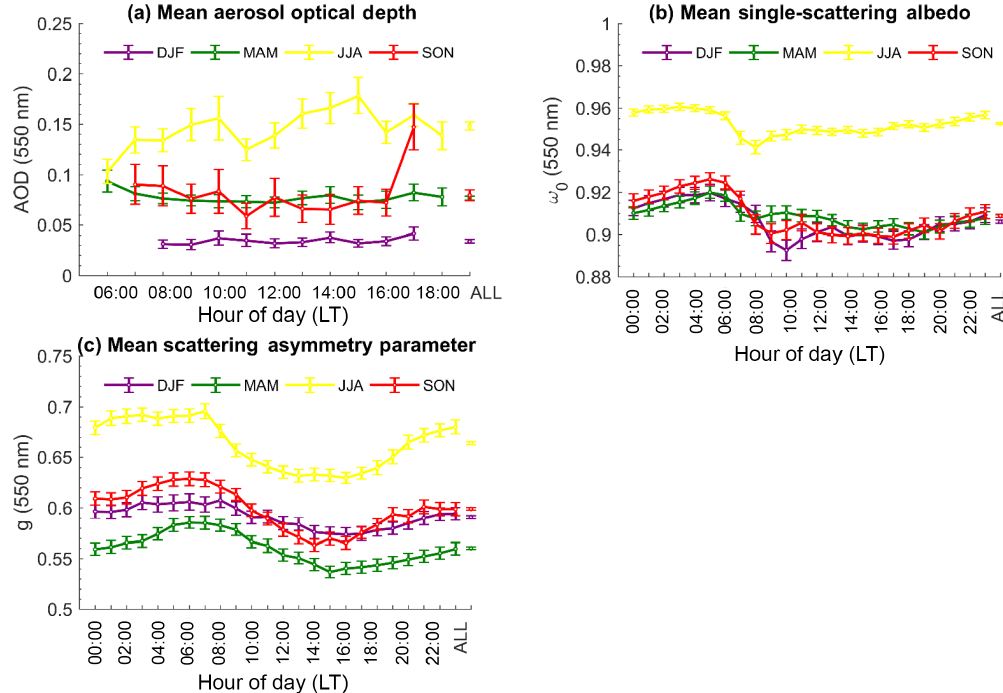
Figure 9. Diurnal cycles of mean (a) AOD; (b) ω 0 ; and (c) g at 550nm for winter (DJF), spring (MAM), summer (JJA), and autumn (SON). The “ALL” points are the mean values over all hours of day. Standard errors of the mean values are plotted as error bars. Table 5. Calculated measurement uncertainties in DRE at the surface, using the sensitivities and correlations given in Table 3 and measure- ment uncertainties given in Table 2 as inputs to Eq. (8). Units of (cid:49) DRE are Wm − 2 . The uncertainties associated with aerosol optical depth are calculated twice: once using AERONET AOD uncertainties and once using the lower bound for MODIS AOD uncertainties (shown in